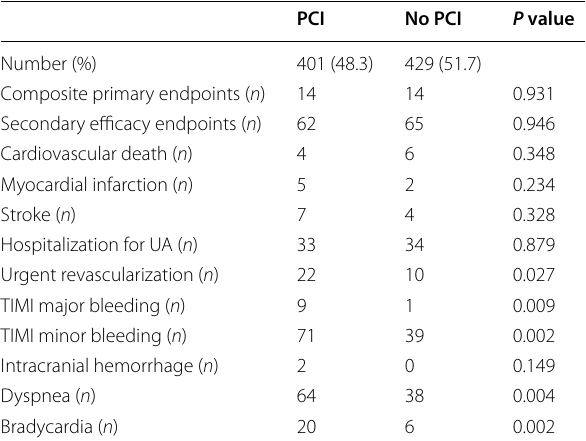
Table 2 Efficacy and safety outcomes in patients who underwent PCI at baseline with those who did not undergo PCI